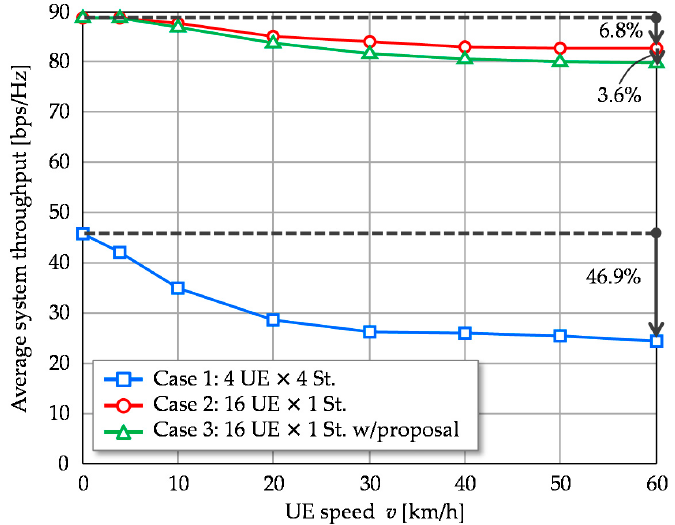
Figure 9. Average system throughput versus UE speed.